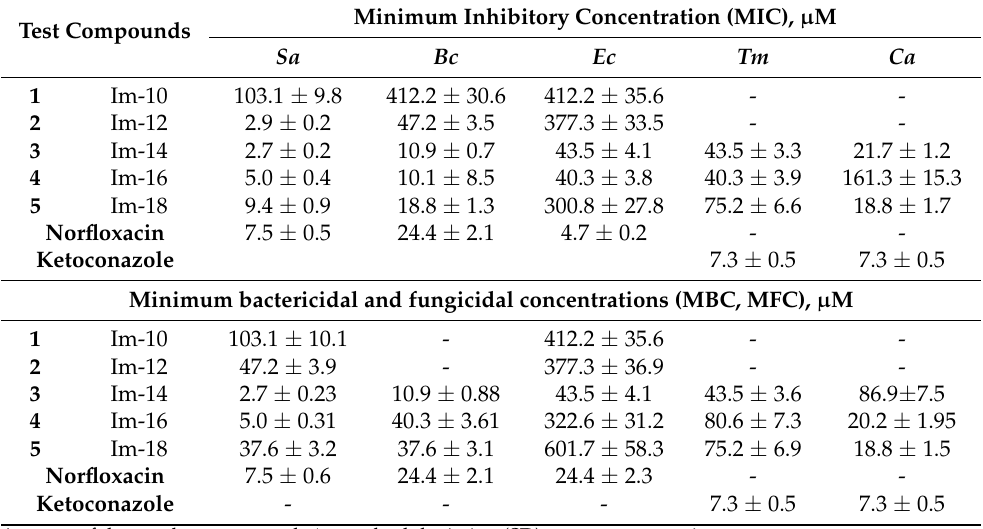
Average of three values measured; ± standard deviation (SD); - means non-active.